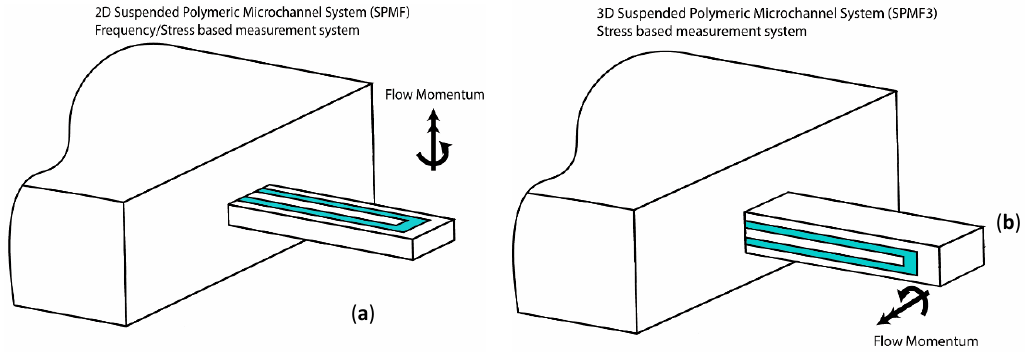
Figure 2. ( a ) 2D suspended microfluidics with the flow plane parallel to the bending (neutral) plane, ( b ) 3D suspended polymeric microfluidics with the flow plane orthogonal to the bending plane.